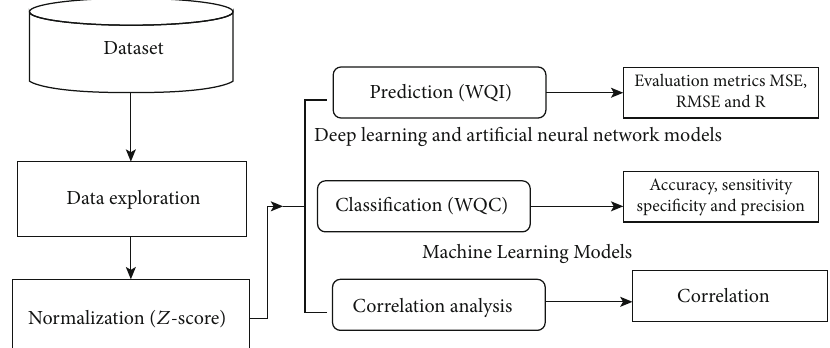
Figure 1: Framework of the proposed